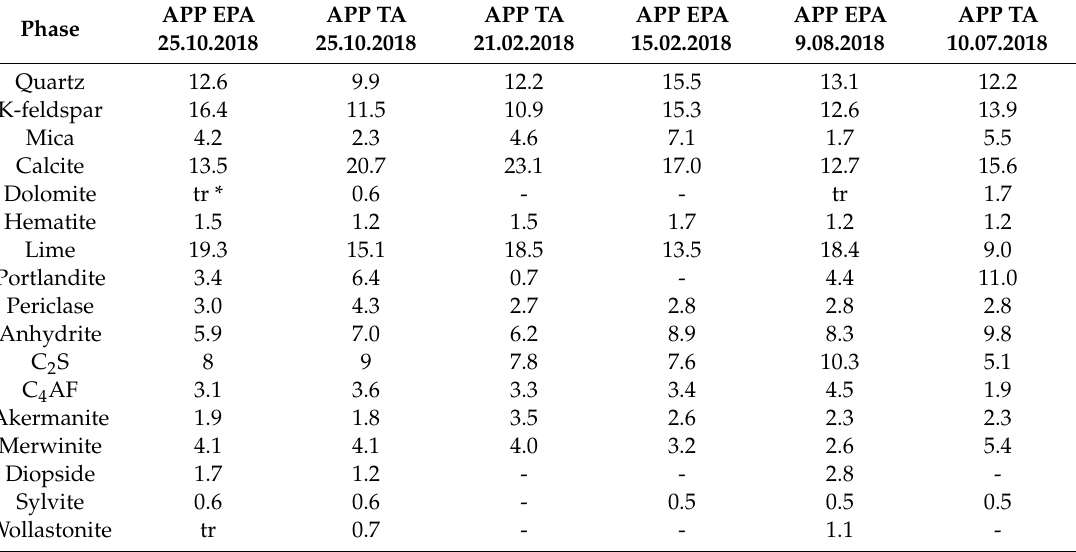
Table 1. Phase composition of APP (EPA, TA).